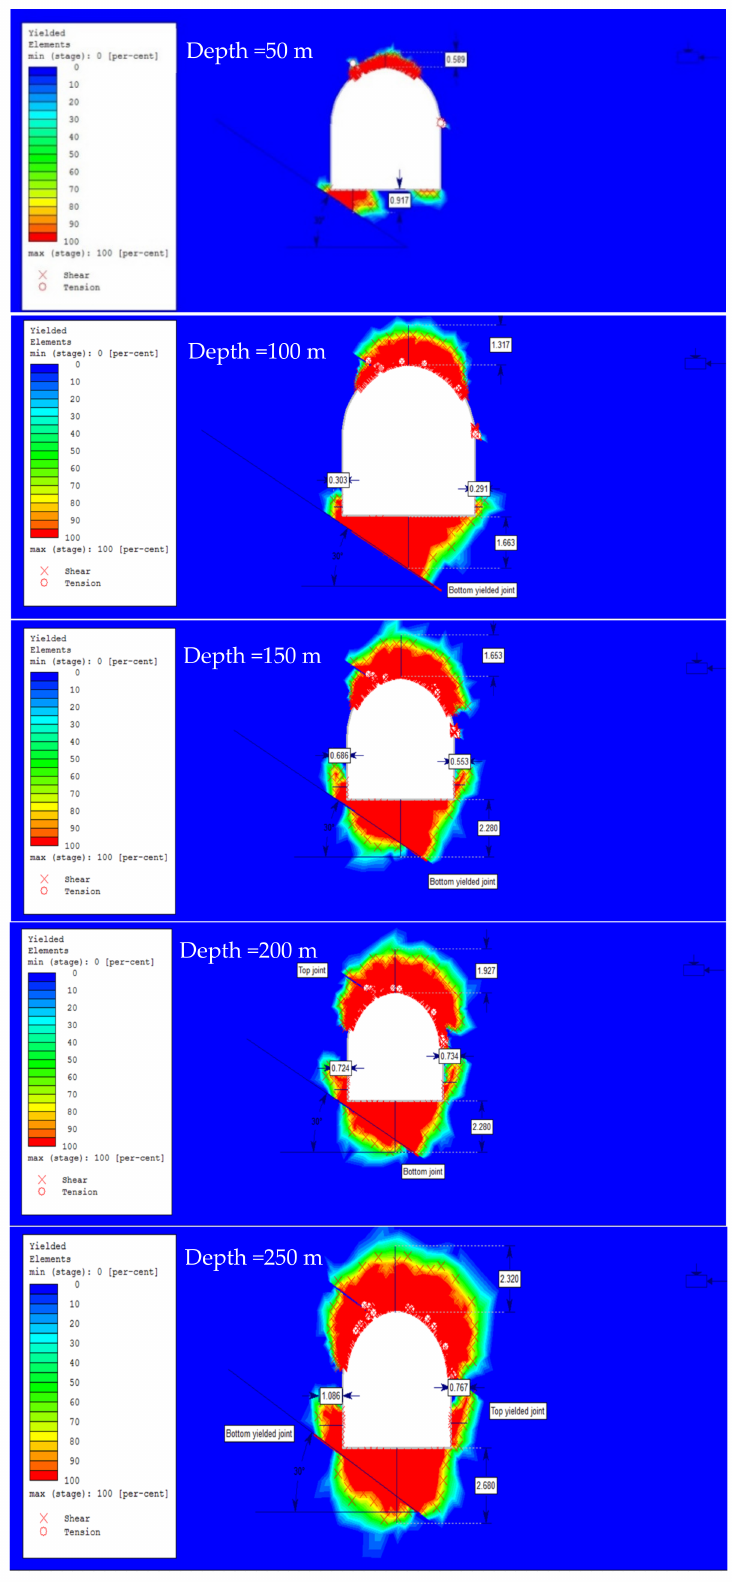
Figure 22. Development of failure zones contours around tunnel opening at various depths be- low